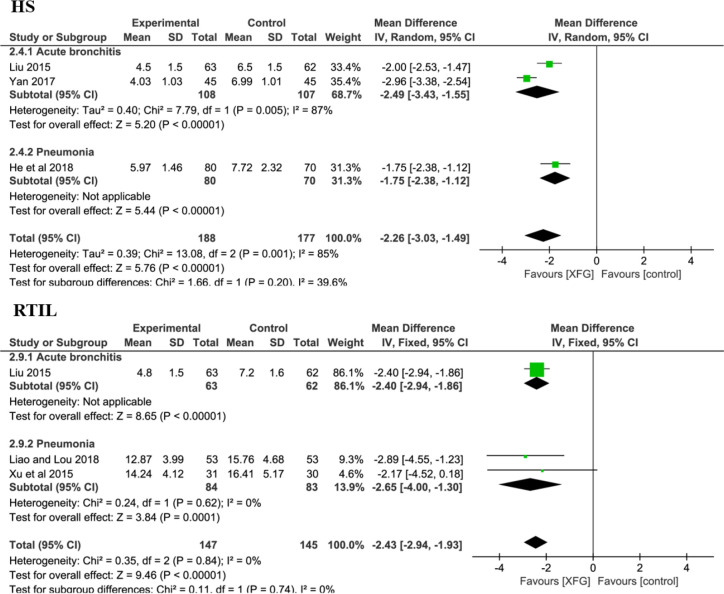
Forest plot and subgroup analysis of the HS and RTIL.